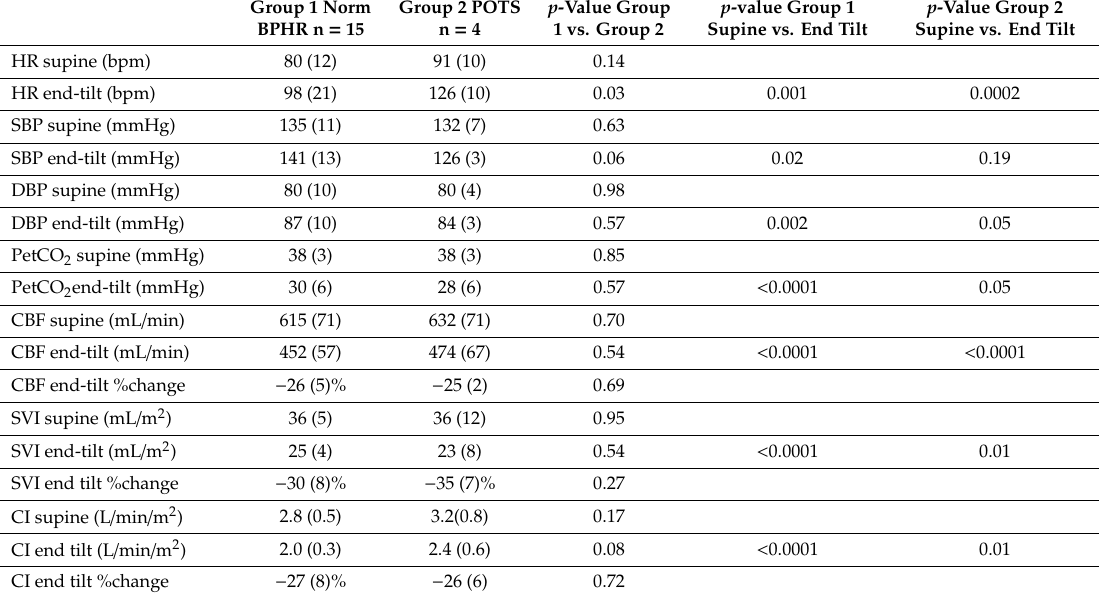
Table 2. Tilt table test data of severe ME / CFS patients: normal heart rate and blood pressure response and postural orthostatic tachycardia syndrome (POTS) response at 20 degrees